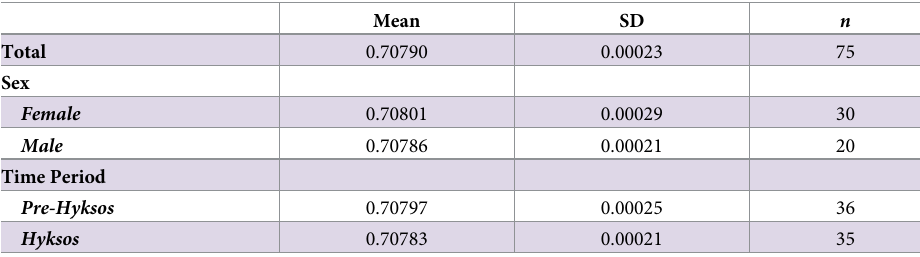
Table 1. Summary of 87 Sr/ 86 Sr results for the site of Tell el-Dab c